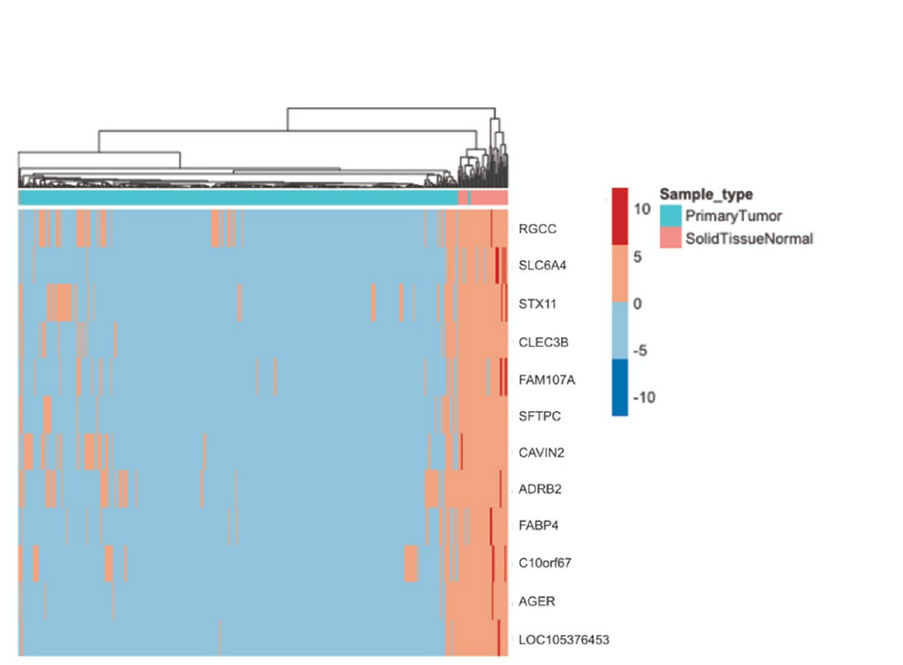
Fig 13. A heatmap representing the expression level of the 12 common candidate genes in LUAD patients in comparison to normal samples. Red represents up-regulation and blue represents down-regulation.